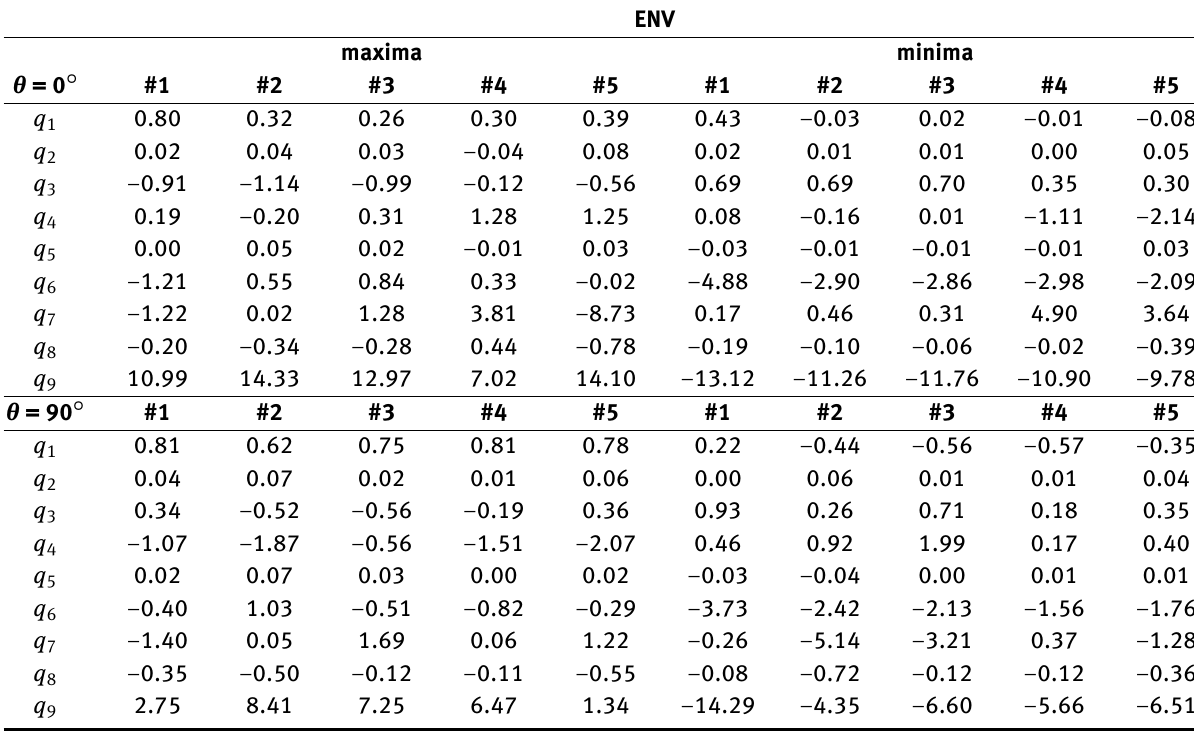
Table 2: Polynomial surface fitting coeflcients for envelope pressure modes (Eq. (2), Figure